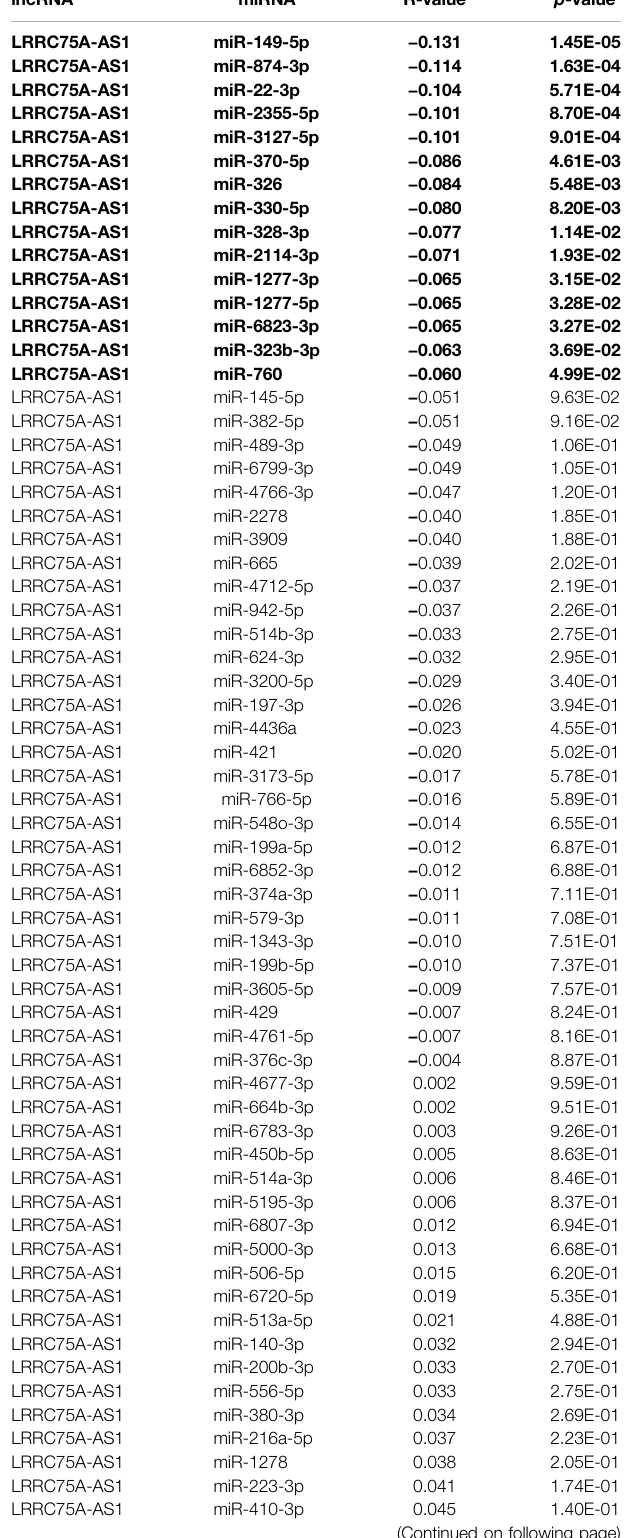
TABLE2| TheexpressioncorrelationofLRRC75A-AS1withpredictedmiRNAsin breast cancer determined by starBase